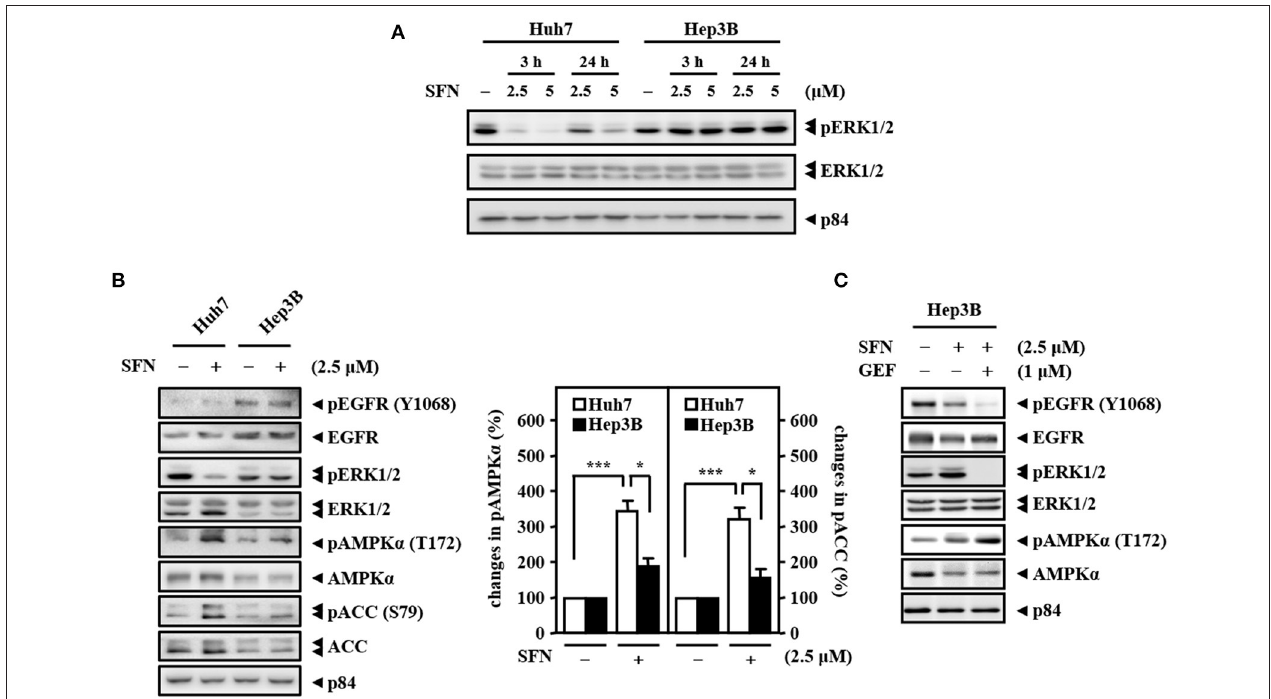
FIGURE 2 | High activity of EGFR and low activity of AMPK determine the primary resistance of Hep3B cells to sorafenib. (A) Huh7 and Hep3B cells were treated with sorafenib at the indicated concentrations for 3 and 24h. Whole cell lysates were harvested for Western blot analyses. (B) Two types of liver cancer cells (Huh7 and Hep3B) were treated with or without sorafenib (2.5 µ M) for 24h and harvested for Western blot analyses. The quantitative analyses of phosphorylated AMPK and ACC were shown in the graphs. (C) Hep3B cells were treated with sorafenib (2.5 µ M) alone or with the combination of sorafenib and the EGFR inhibitor gefitinib (GEF; 1 µ M) for 24h. Whole cell lysates were harvested for Western blot analyses. The data are shown as the mean ± SD. * P < 0.05; ** P < 0.01; *** P < 0.001 by Student’s t